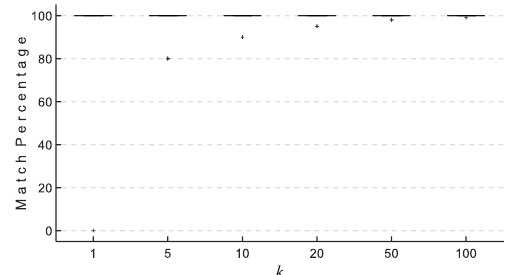
Figure 9 Match percentage of Postgres-v1 and Postgres-v2 Postgres-v1 and Postgres-v2 match perfectly regardless of the value of k except the outliers. For instance, there are three outliers when k =5. The closest four nearest neighbours are common in both Postgres-v1 and Postgres-v2; hence, the match percentage is 80%. Consequently, the most distant nearest neighbour is not common, since these points are equidistant to the query point but have different locations. When the third outlier is analysed, it is observed that Postgres-v2 detected a point that is actually farther from what Postgres-v1 had detected. It should also be noted that the opposite situation have also been observed when k =20, in which the spatial accuracy of Postgres-v1 is better than Postgres- v2. Last, it should be noted that two or more pickup locations could exactly be the same, which also contributes to the existence of